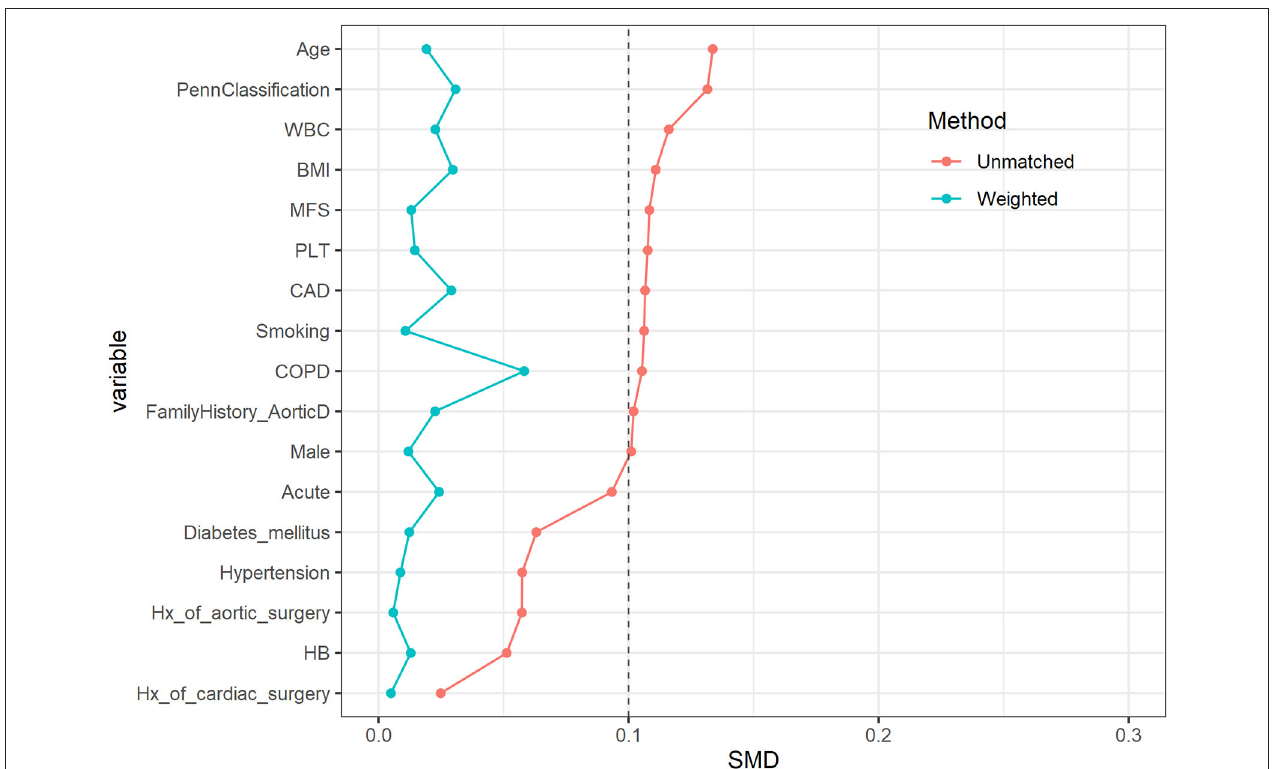
FIGURE 1 | Love plot before and after propensity score matching (PSM) among characteristics. The distribution of main variables was stable after matching.